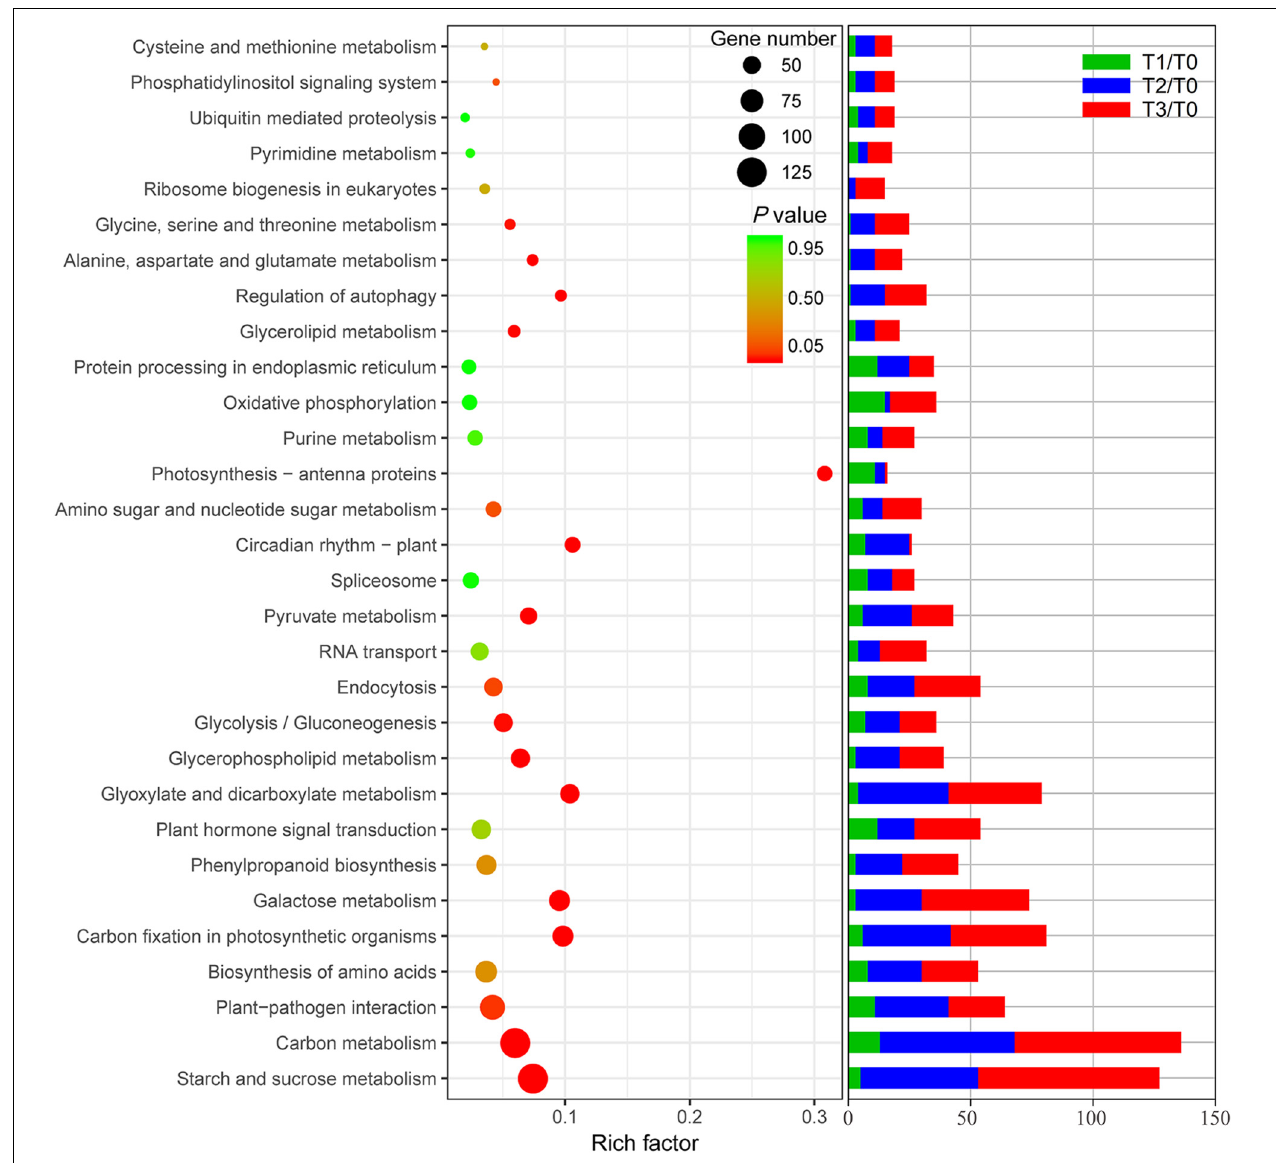
FIGURE 4 | KEGG enrichment of differentially expressed mRNAs and mRNAs of different pathways in different comparison